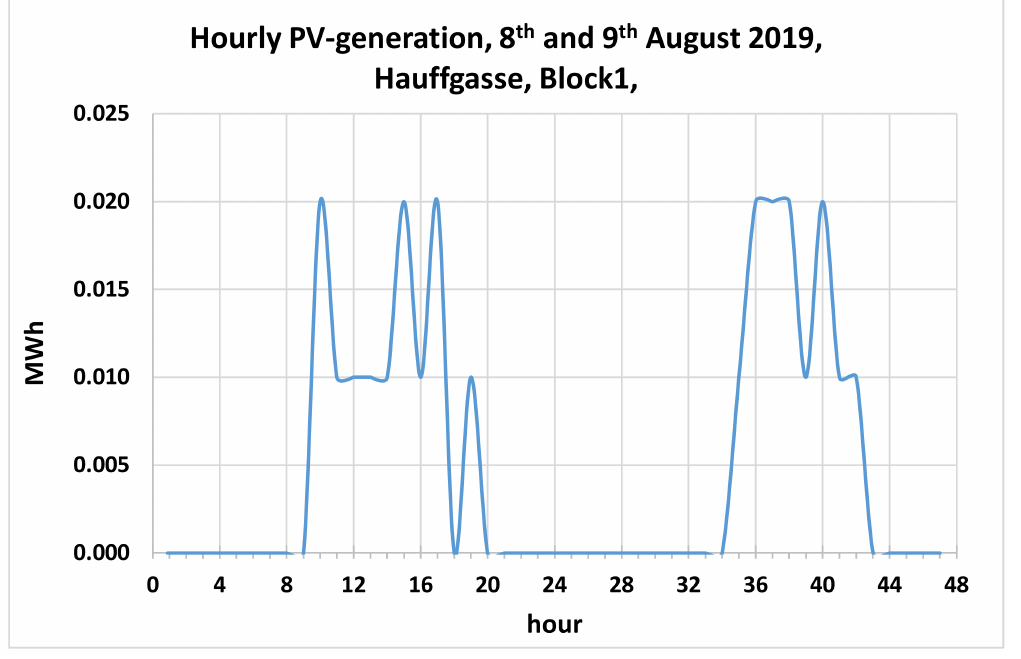
Figure 11. Monitored data of PV production on 8th and 9th August, Hauffgasse, Vienna. 8th and 9th August 2019.